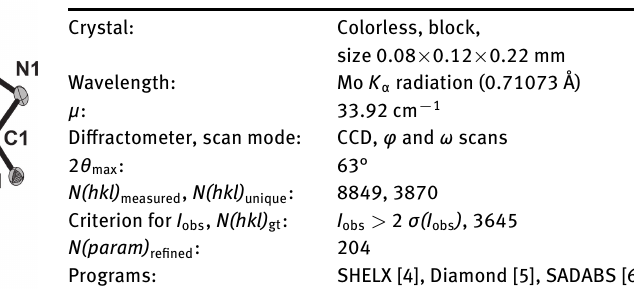
Table 1: Data collection and handling.